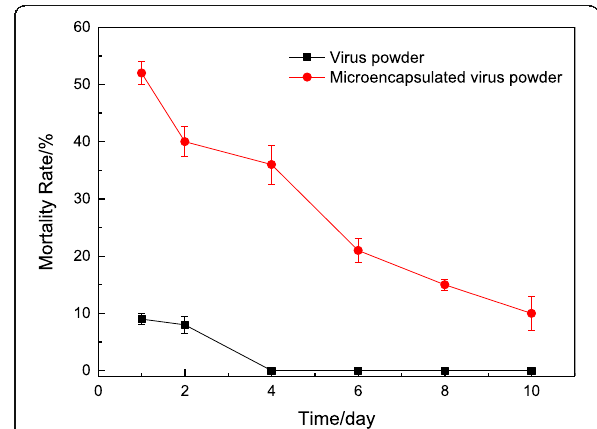
Fig. 9 Infection mortality of Spodoptera litura larvae after field